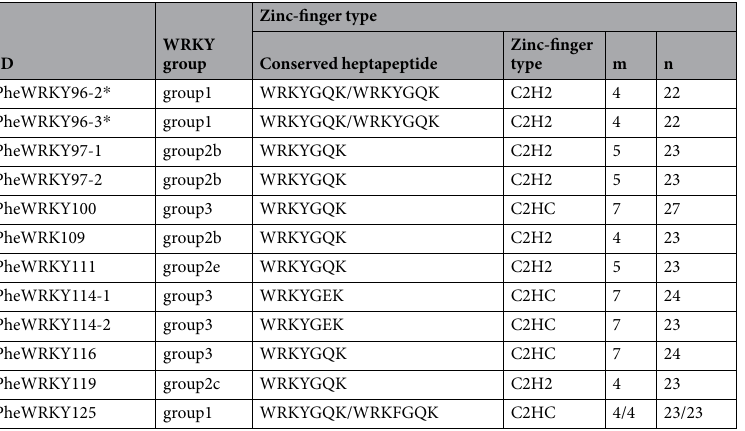
Table 1. The WRKY genes in P. edulis . Note: * Indicates the amino acid sequences in group1 have only one integrity WRKY domain and the structure of second WRKY domain delete zinc-finger motif; ‘m’ and ‘n’ refer to the number of residues present in the consensus zinc finger motif